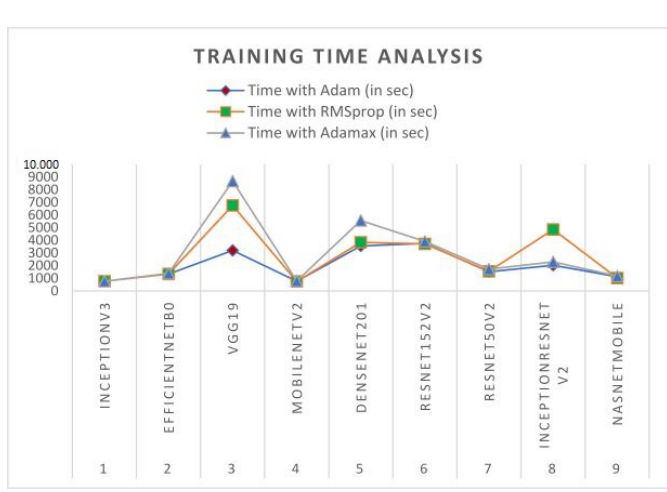
Figure 8. Computation time analysis of the pre-trained